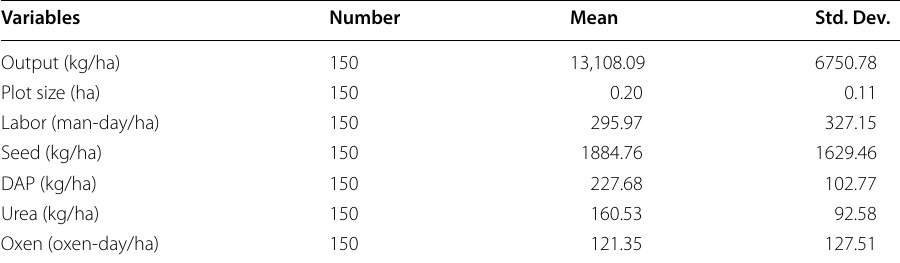
Table 3 Summary statistics of variables for stochastic production function analysis. Source: Computed from Field Survey Data, 2015/16